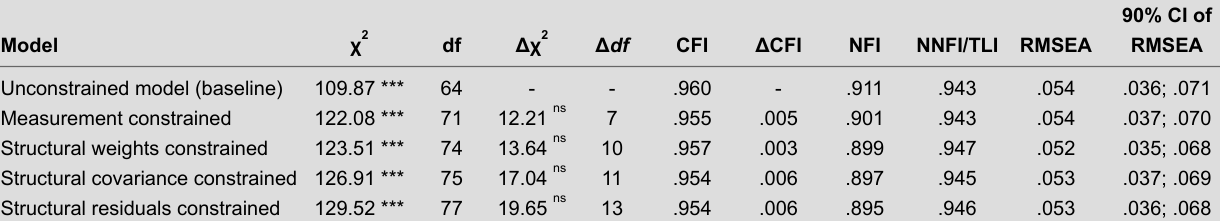
Tests for Invariance of Hypothetical Model